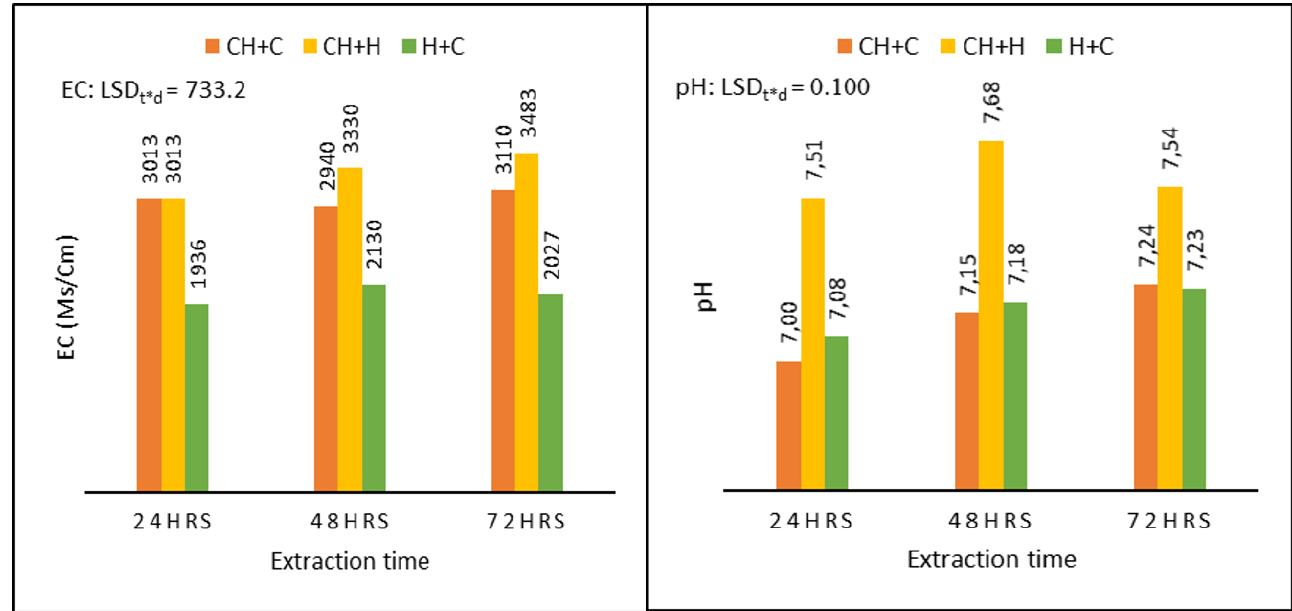
Figure 5. Measure of EC and pH in different vermicompost teas over 72-h extraction period.